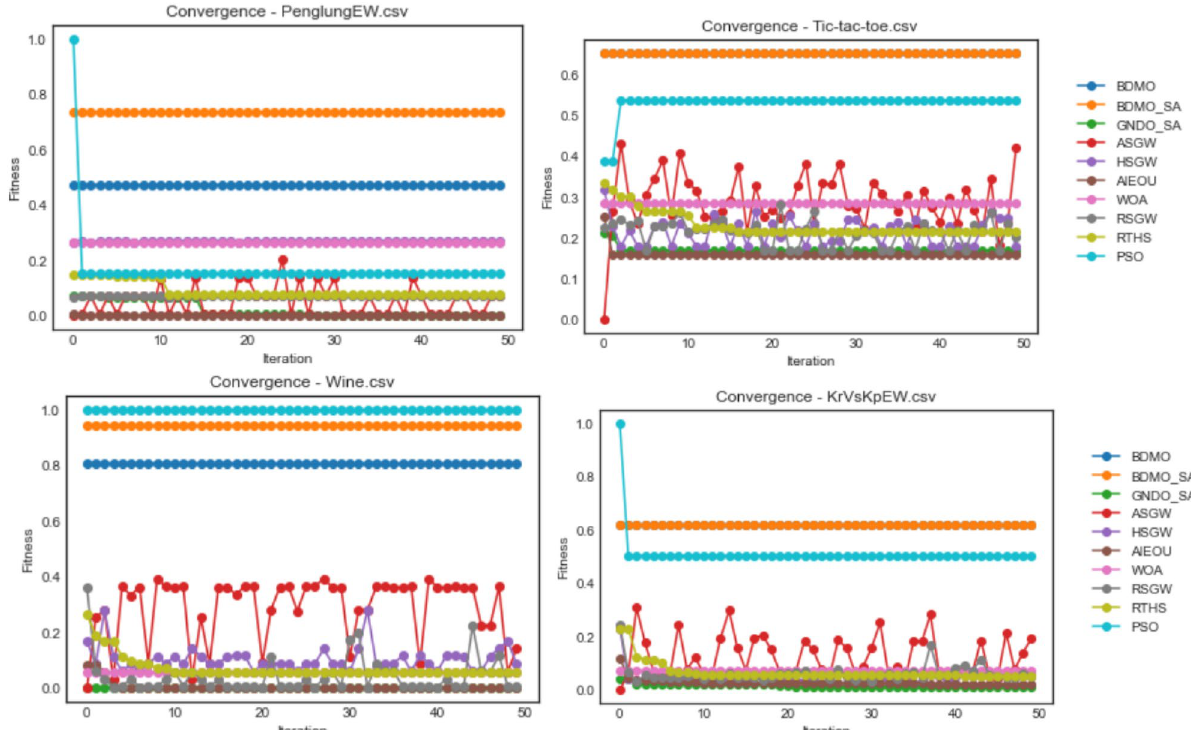
Figure 5. Convergence behavior of all algorithms on PenglungEW, Tic-tac-toe, Wine, and KrVsKpEW